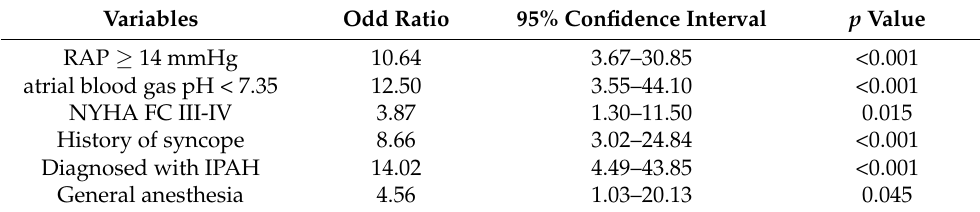
Table 4. Odds ratio of pulmonary hypertensive crisis in the whole